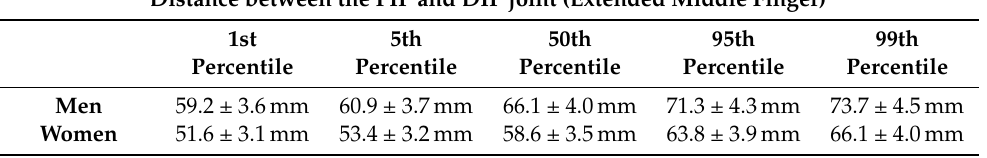
Table A5. Distance between the Proximal Interphalangeal (PIP) and Distal Interphalangeal (DIP) joint with an extended middle